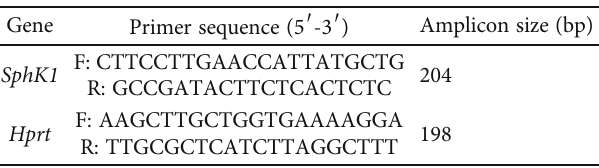
Table 1: Hypoxanthine – guanine phosphoribosyltransferase (hprt), housekeeping, and target gene primer sequence. SphK: sphingosine